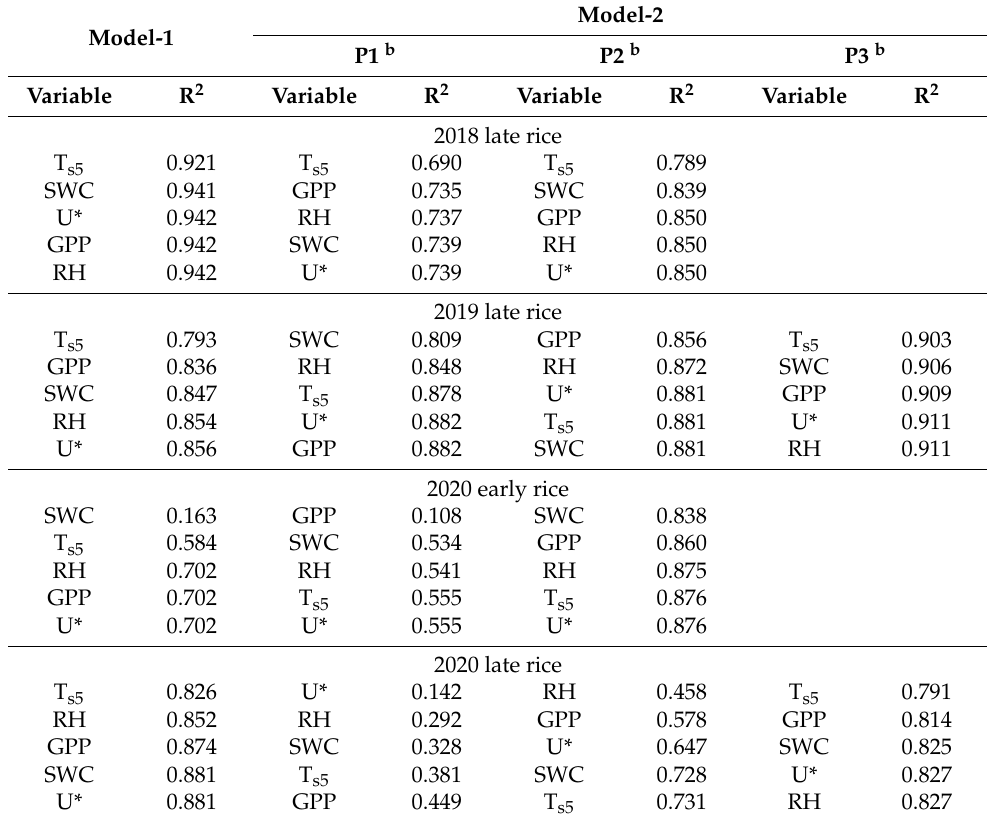
Table 2. Coefficients of determination (R 2 ) a for the stepwise multivariate regression